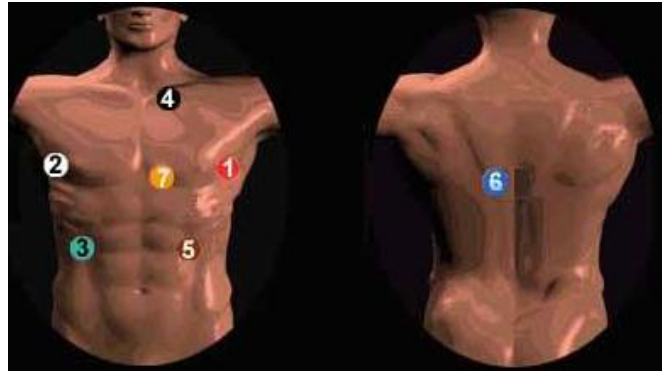
Figure 1. Position of the Holter ECG heart rate measurement electrodes.